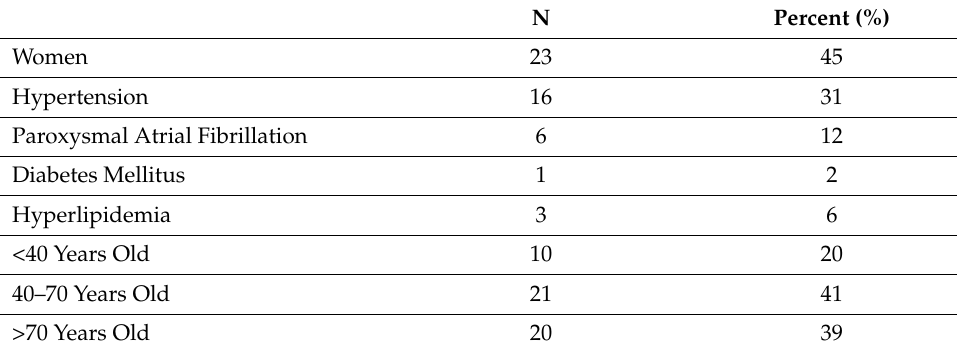
Table 1. Baseline characteristics of 51 included